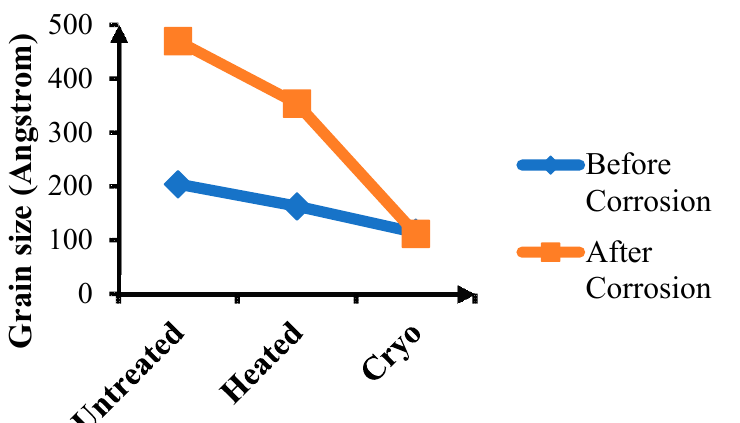
Figure 5. Grain size variation for untreated, conventionally heat-treated and 16 h cryogenically treated specimens before and after corrosion.